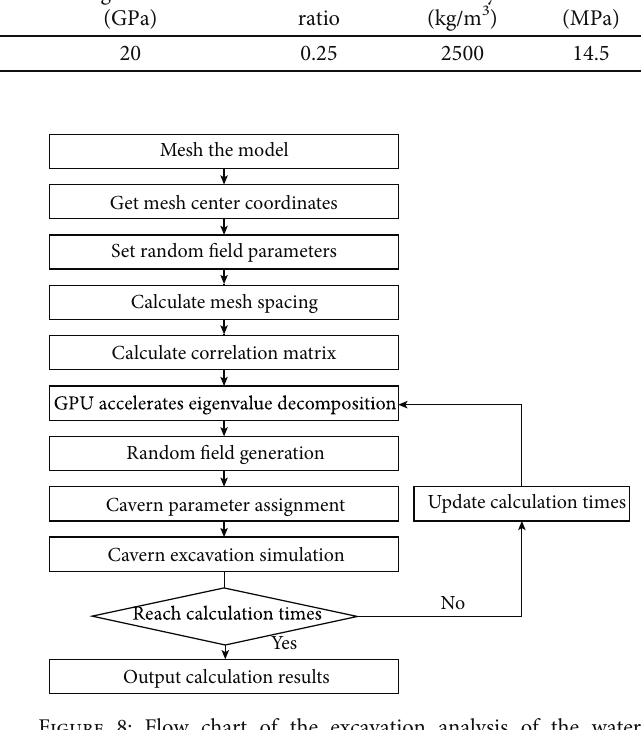
Figure 8: Flow chart of the excavation analysis of the water diversion tunnel in central Yunnan based on the random fi eld